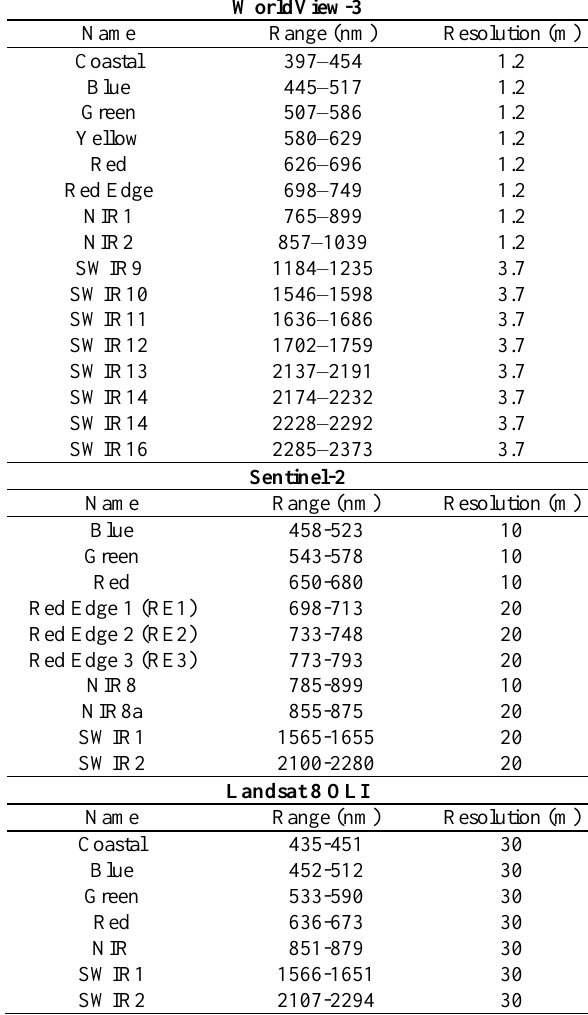
Table 1 . Bands of WorldView-3, Sentinel-2, and Landsat 8 OLI used in this study.